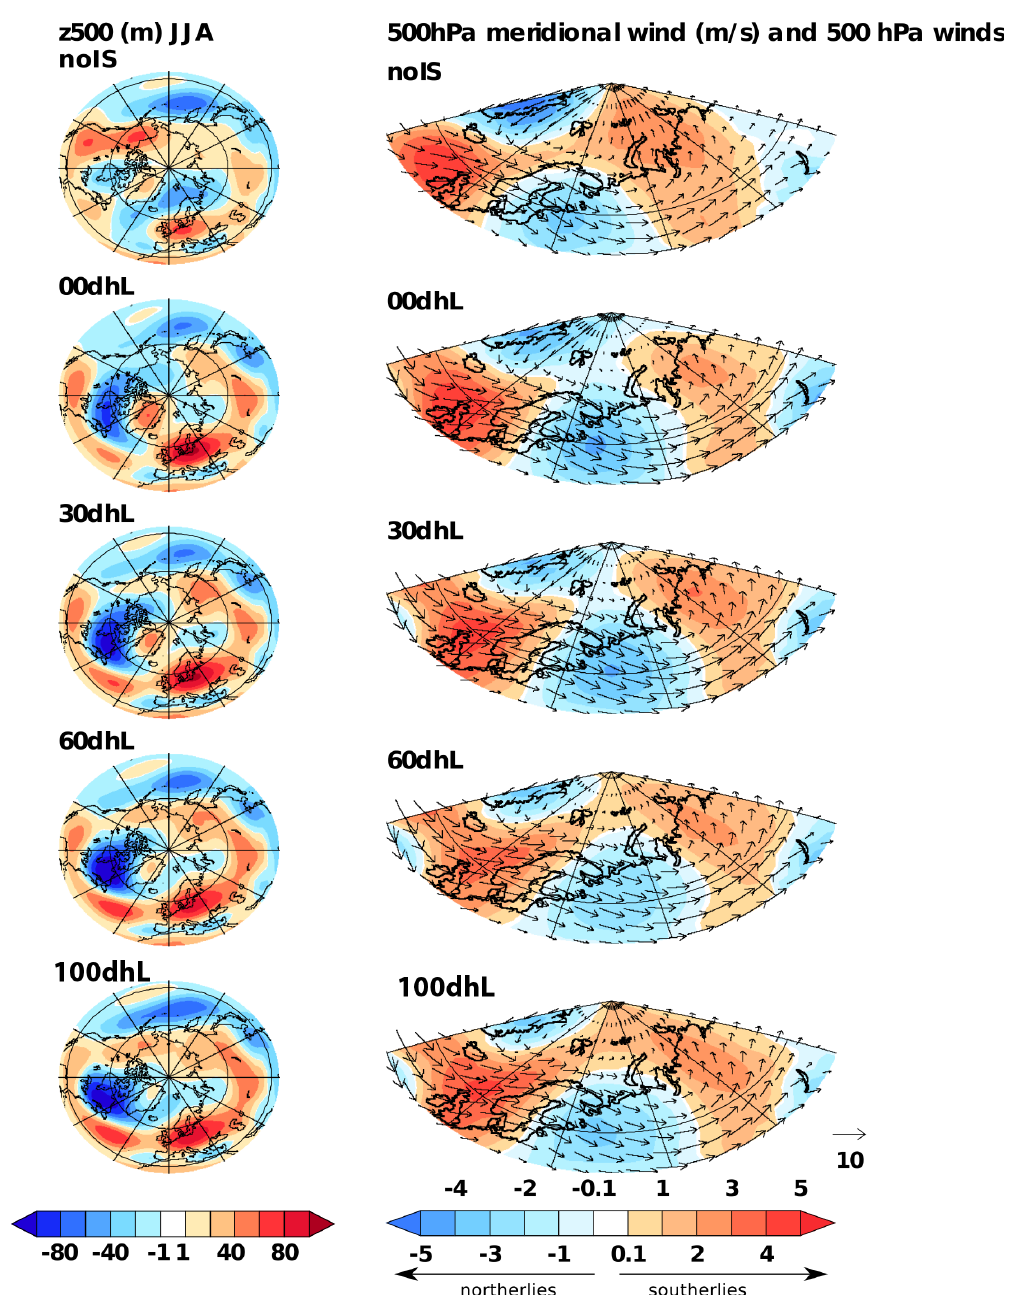
Figure 4. 500hPa summer geopotential height anomaly from zonal mean (left panels) and 500hPa horizontal wind (arrows) and meridional wind (shaded, right